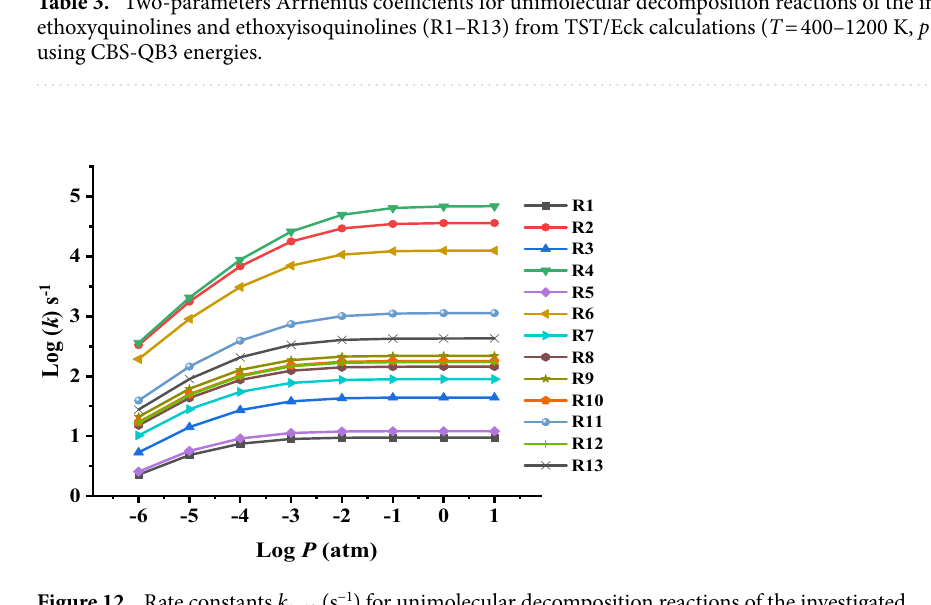
Figure 12. Rate constants k 1−13 (s −1 ) for unimolecular decomposition reactions of the investigated ethoxyquinolines and ethoxyisoquinolines (R1–R13) obtained from pressure-dependent RRKM theory based on CBS-QB3//BMK/6–31+G(d,p) energies, ( T = 800 K, P = 10 −6 –10